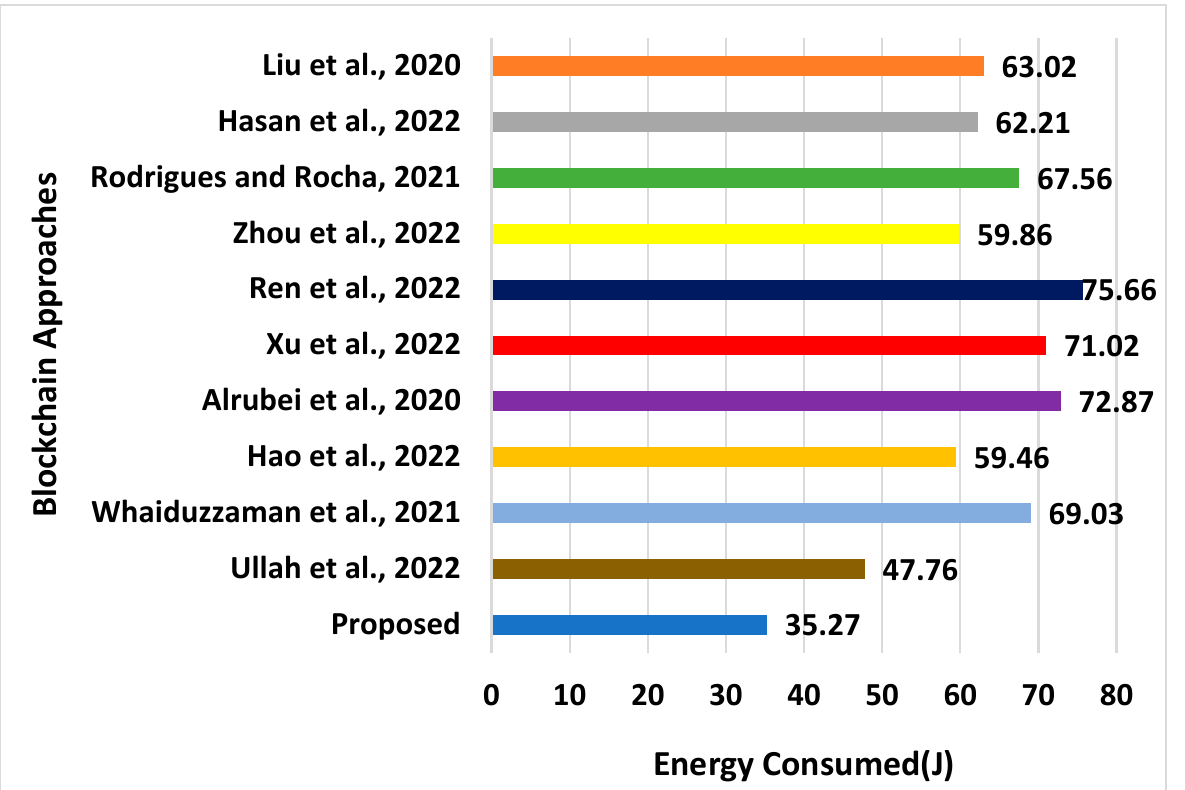
Figure 2. Analysis of energy consumption [39–48].